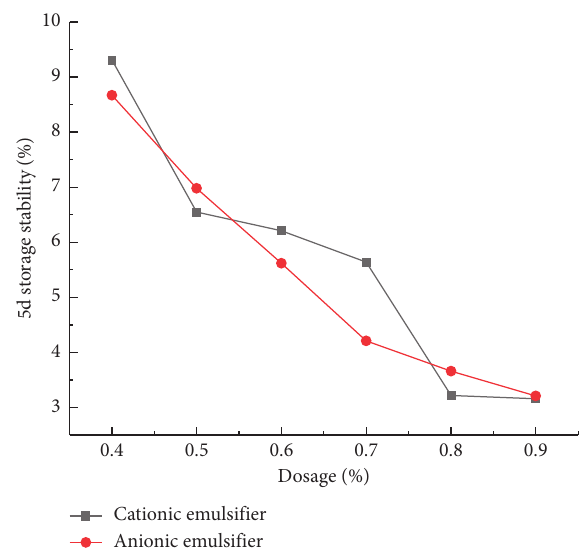
Figure 3: The effect of stabilizer dosage on 5d storage stability.